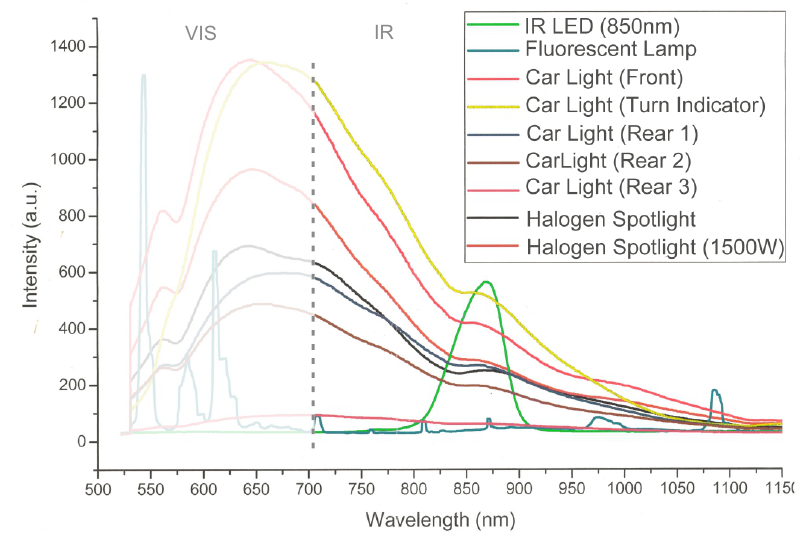
Figure 7. Wavelengths of various light